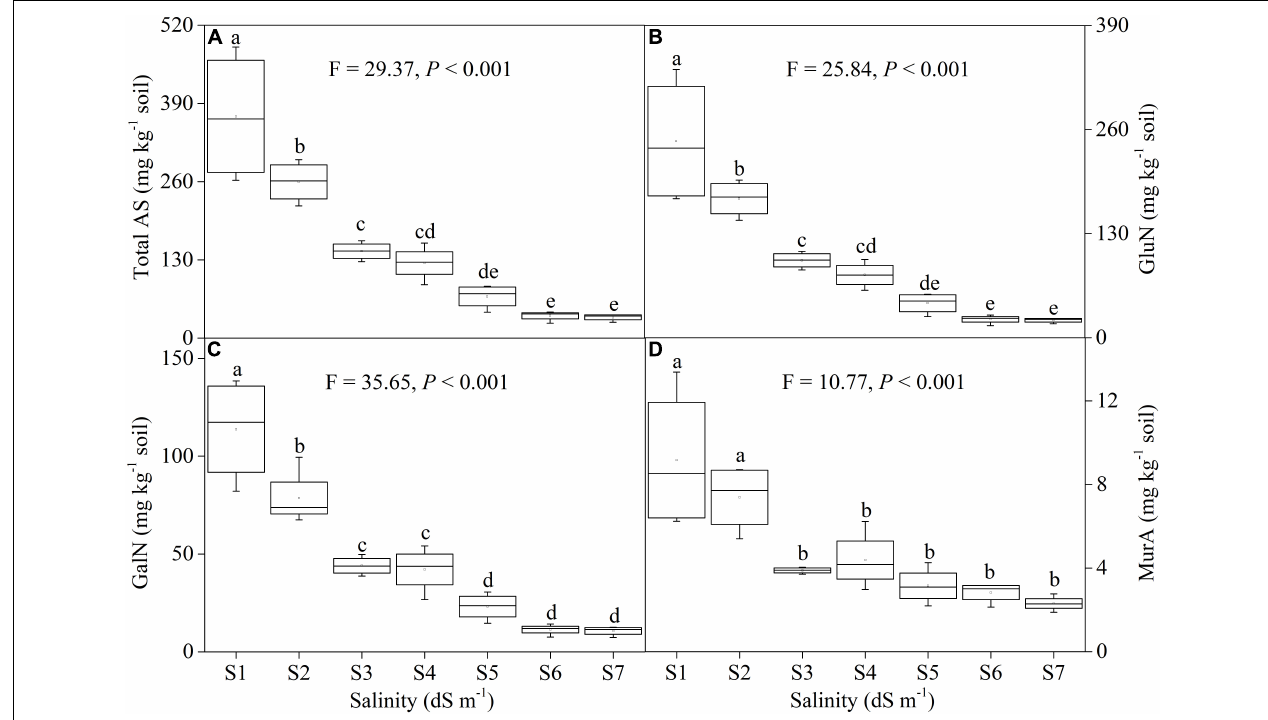
FIGURE 2 | Changes in the content of soil total amino sugar (AS, A ), glucosamine (GluN, B ), galactosamine (GalN, C ), and muramic acid (MurA, D ) along a soil salinity gradient.